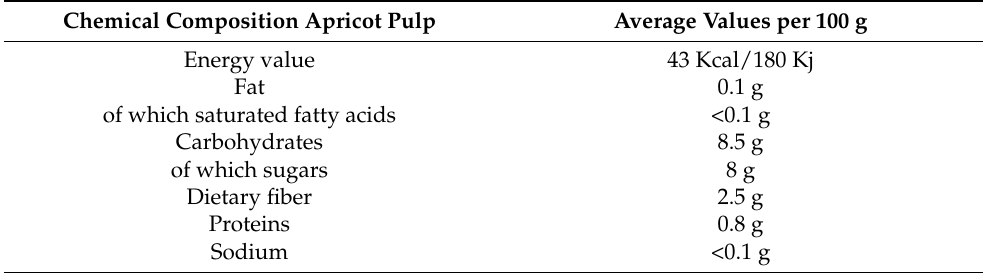
Table 9. Chemical composition of apricot pulp with average values per 100 g. Chemical Composition Apricot